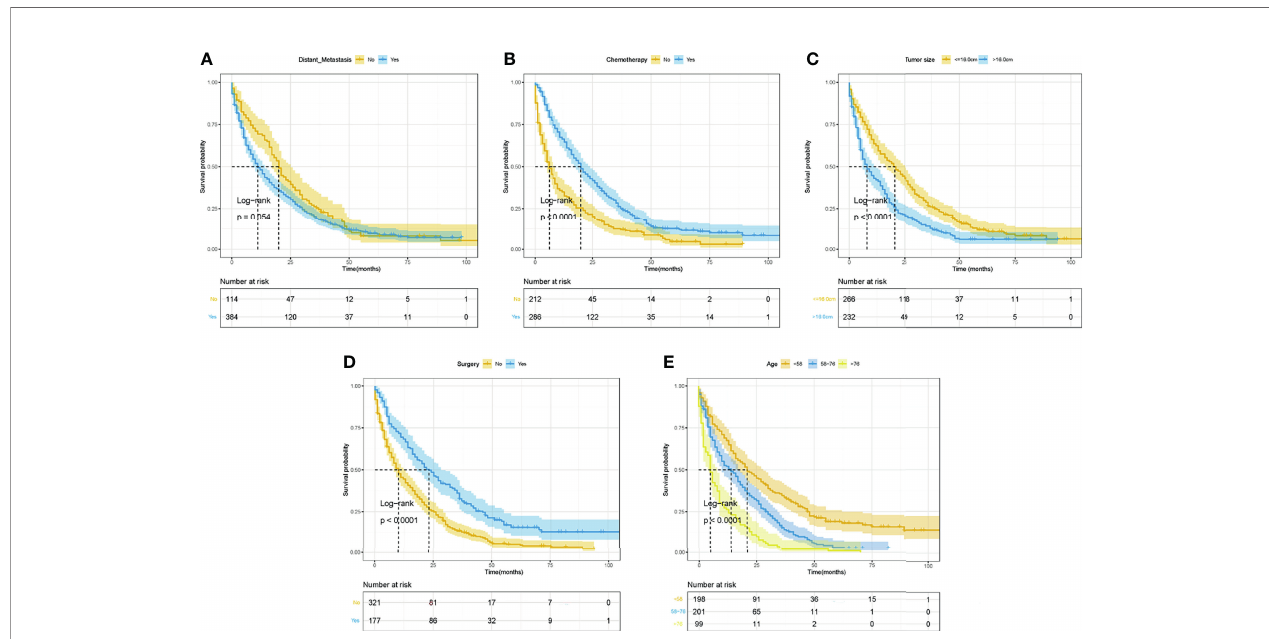
FIGURE 3 | The Kaplan – Meier curves for OS based on variables for the nomograms. (A) Distant metastasis. (B) Chemotherapy. (C) Tumor size. (D) Surgery. (E) Age. ROC, receiver operating curve; OS, Overall Survival.